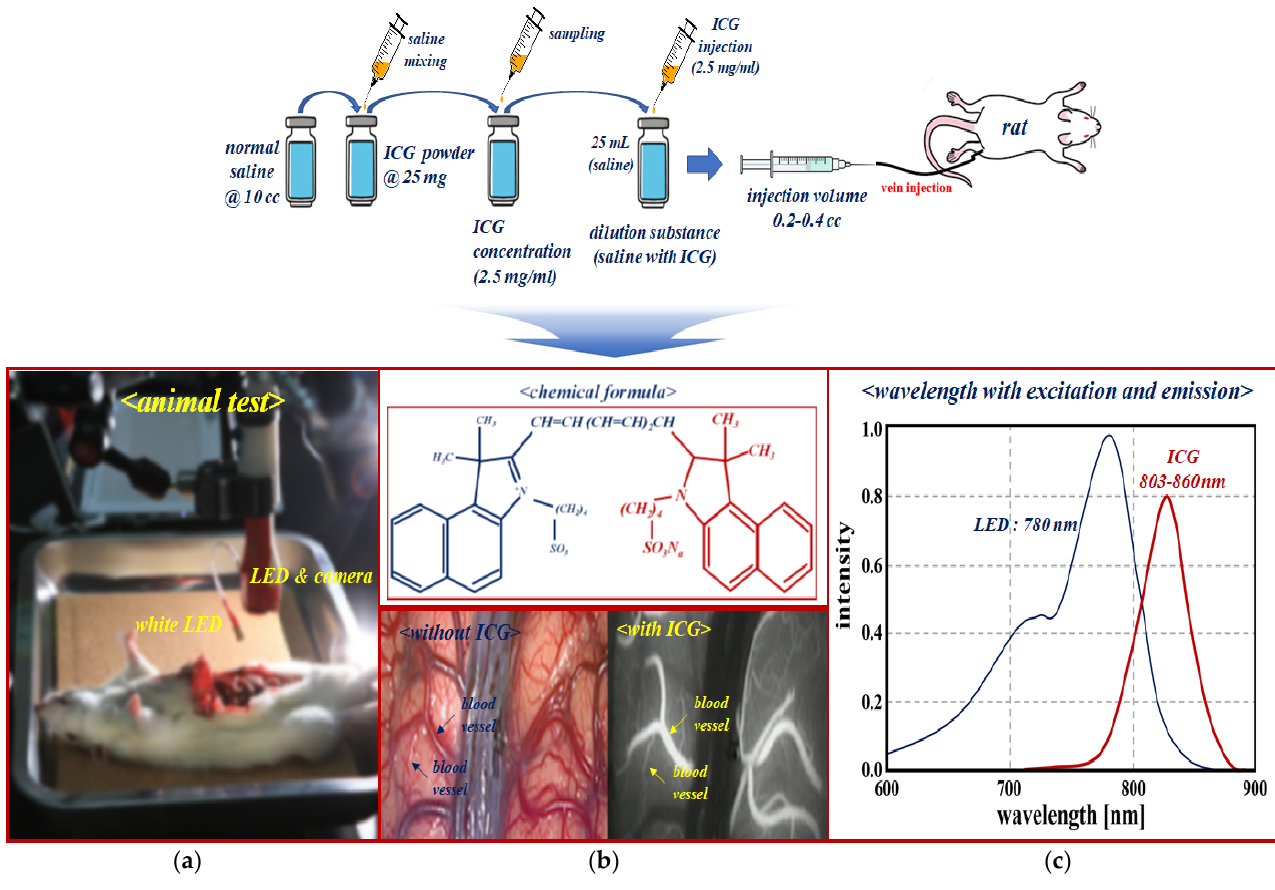
Figure 14. ICG mechanism of action and emission wavelength band ( a ) Fluorescence detection after injection. ( b ) ICG chemical formula. ( c ) ICG fluorescence emission wavelength.